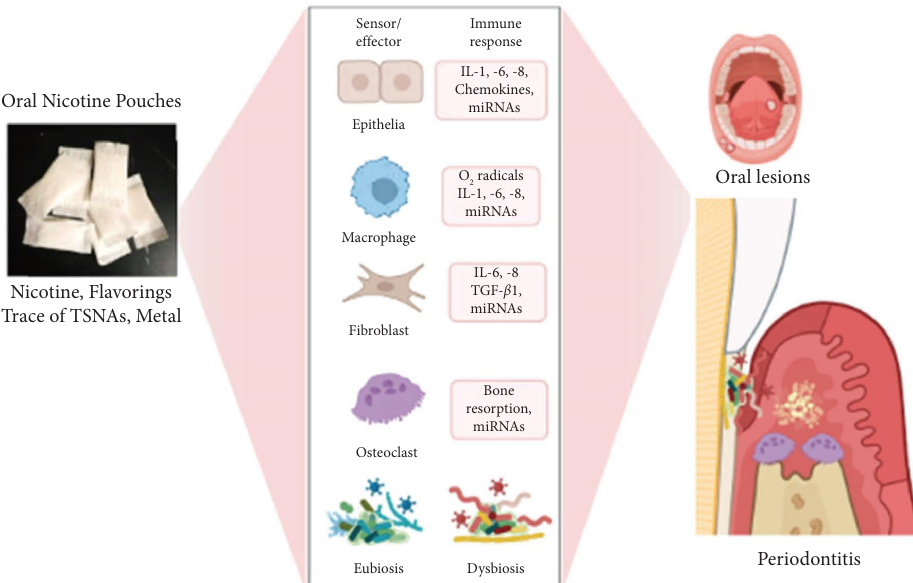
Figure 1: Schematic mechanism showing ONPs cause oxidative stress/infammation/immune dysfunction, dysbiosis, and miRNAs dysregulation on periodontal health, which was prepared using